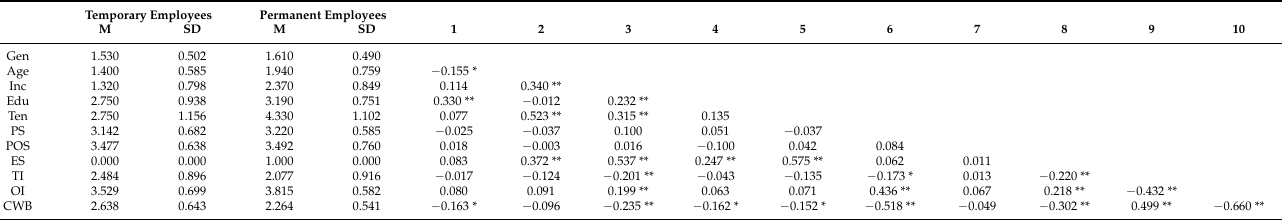
Table 3. Means, Standard Deviations, Correlations of